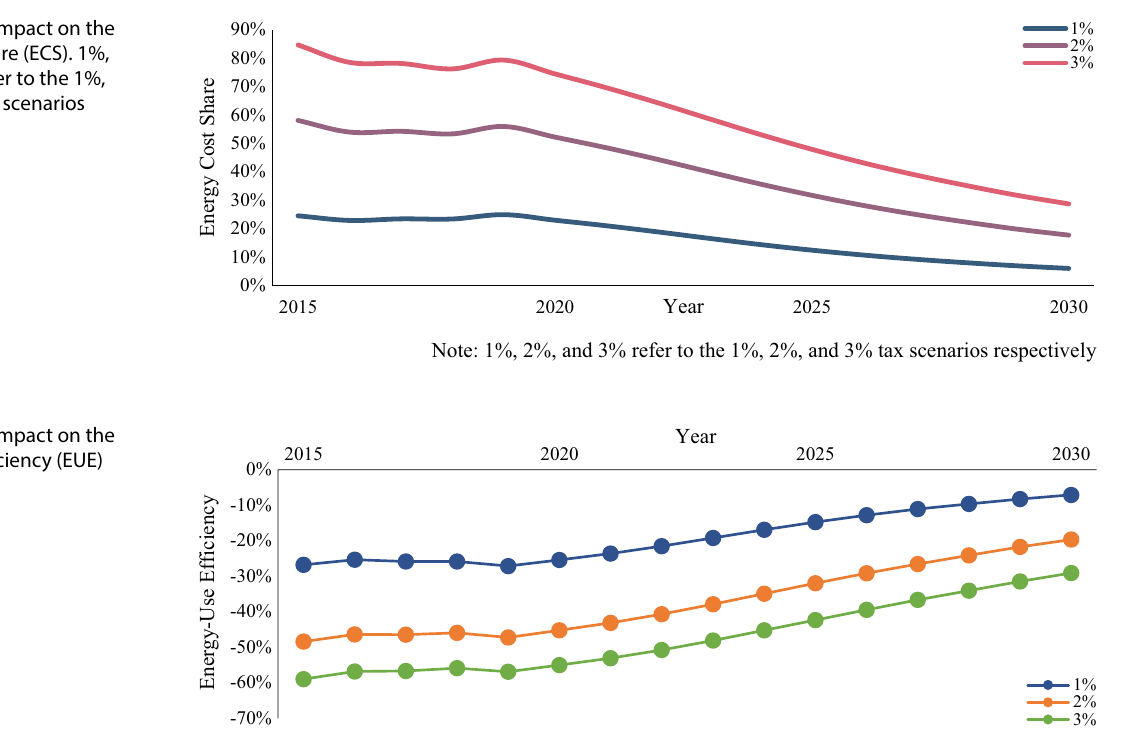
Fig. 1 The ITC impact on the energy cost share (ECS). 1%, 2%, and 3% refer to the 1%, 2%, and 3% tax scenarios respectively